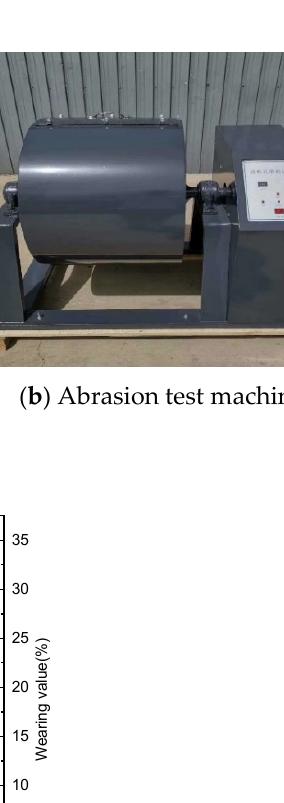
Figure 6. Test machines.